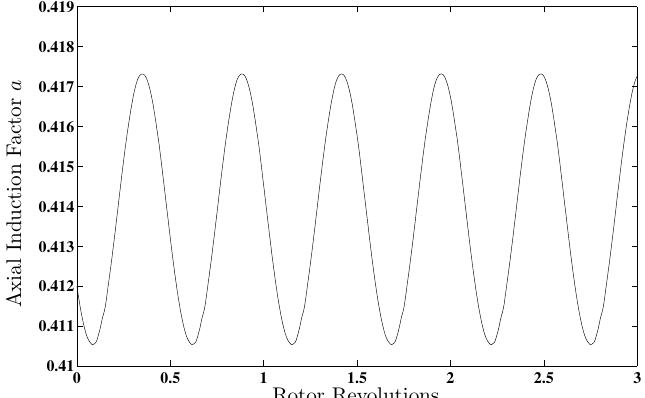
Figure 4. Axial induction factor a , at 90% of blade length, for a de-loaded NREL-5MW reference turbine rotating at 15 rpm at a wind velocity of 8 m/s.